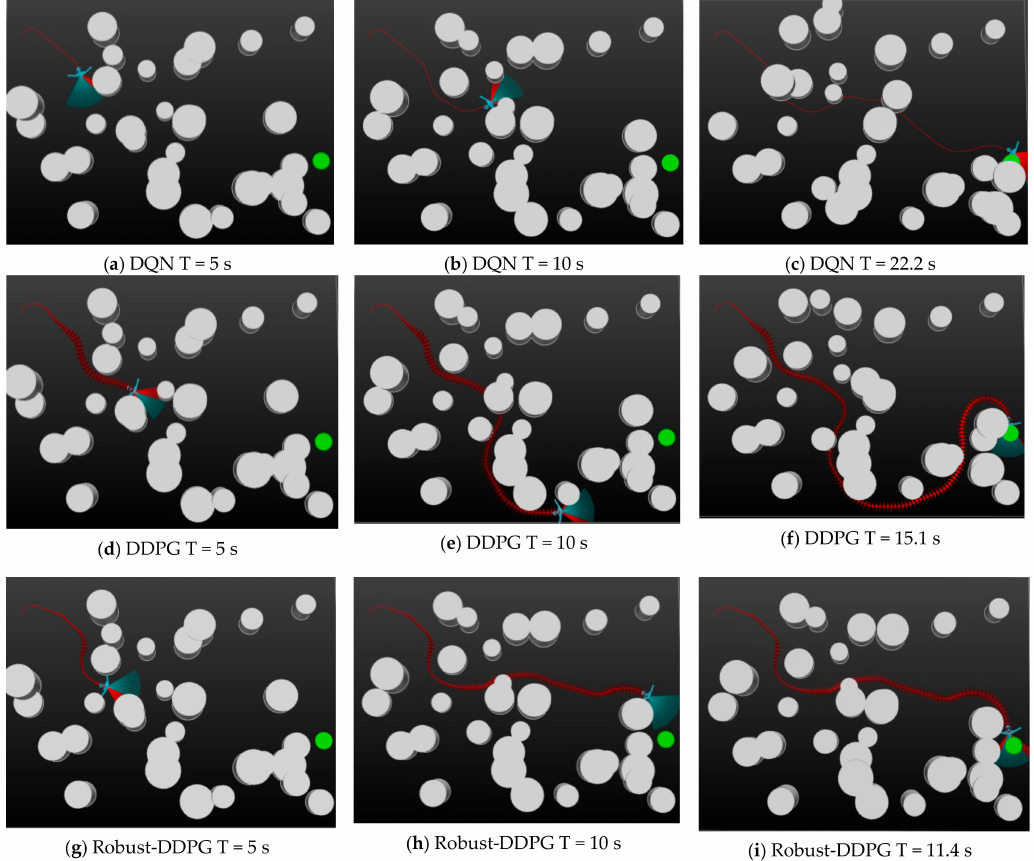
Figure 8. UAV flying trajectories drove by three di ff erent controllers. DQN flies 22.2 s and 463.2 m, DDPG flies 15.1 s and 651.1 m, Robust-DDPG flies 11.4 s and 443.5 m to reach the target.